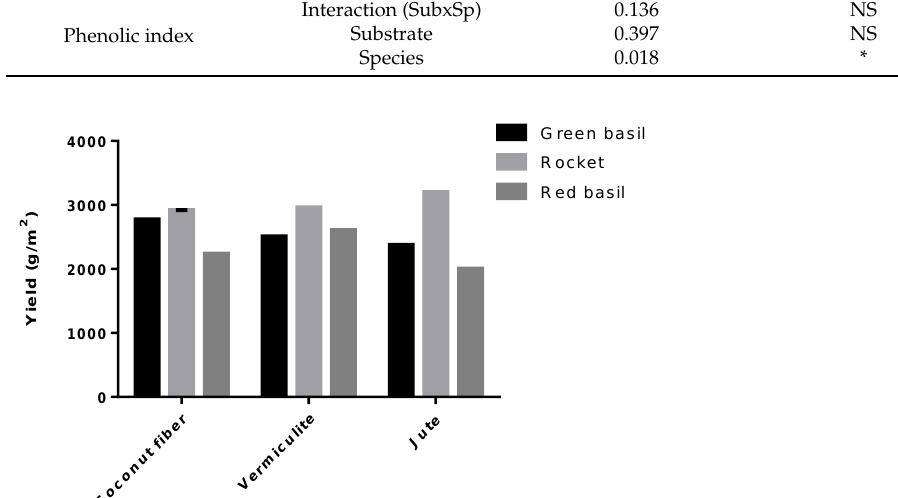
Figure 3. Yield of green basil, rocket, and red basil microgreens grown on three different substrates (coconut fiber, vermiculite, and jute). Values, subjected to two-way ANOVA, are means ± SE (n = 6).